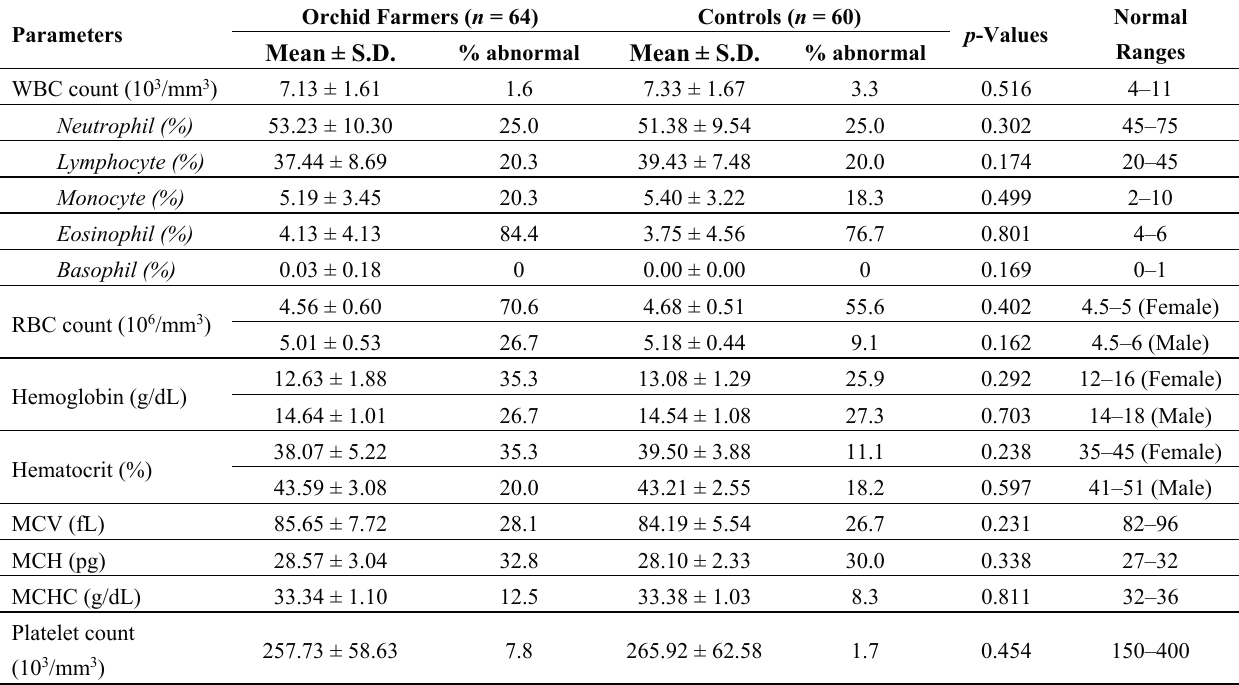
Table 8. Hematological profile of orchid farmers and controls (Mean ±